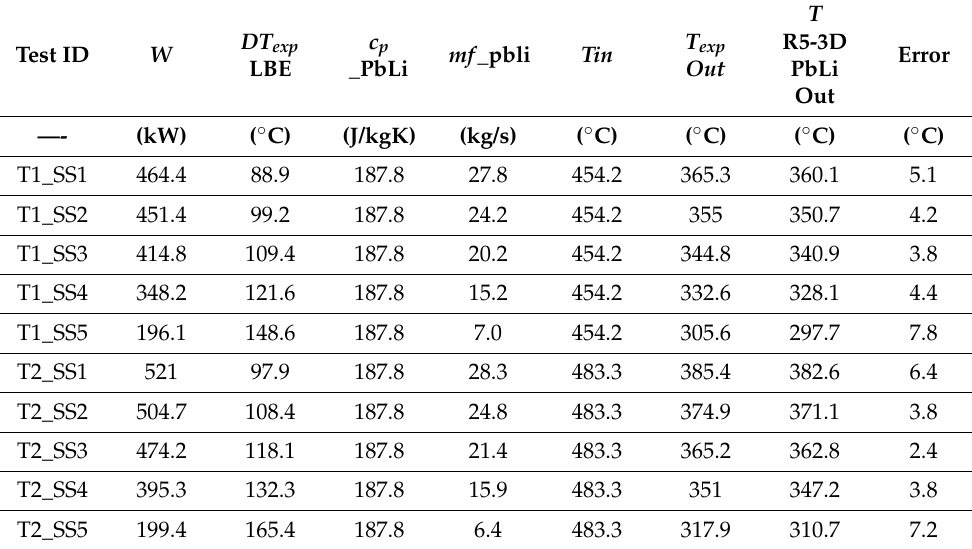
Table 5. CIRCE-HERO EF-T1 and EF-T2, equivalence between LBE and PbLi using method #2, preserving power and temperatures: experimental vs. RELAP5-3D